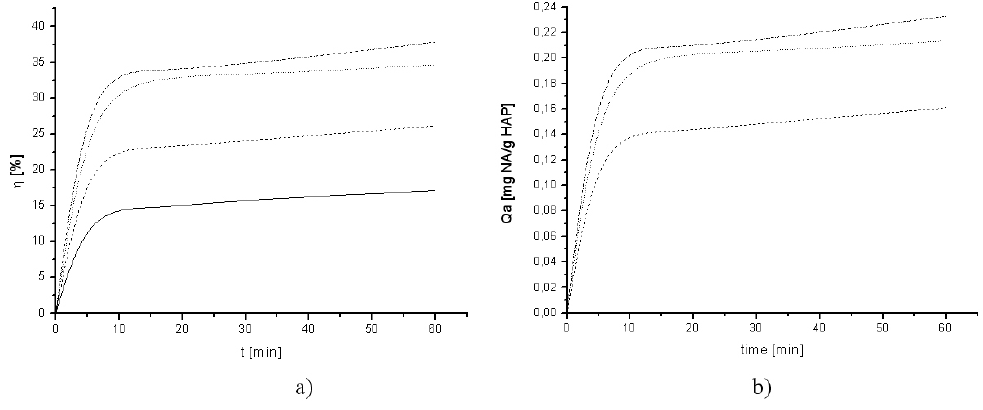
Figure 4. The adsorption efficiency (a) and capacity (b) of HAP (solid line), HAP-Si 5 wt% Si (dashed line), HAP-Si 10 wt% Si (short dotted line) and HAP-Si 10 wt% Si doped with copper (dash dotted line) Table 2. Correlation coefficients and rate constants for the kinetic models at 15, 20 and 30 o C T Pseudo-first order kinetic model Pseudo-second order kinetic